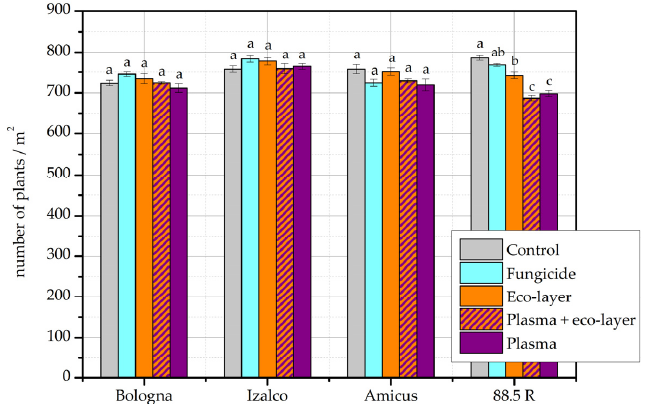
Figure 2. The number of emerged plants per m 2 according to individual treatments and cultivars in the year 2020/21. The error bars represent standard error. Different lowercase letters above data points represent statistically significant differences ( p < 0.05; post hoc Tukey’s range test) between treatments.